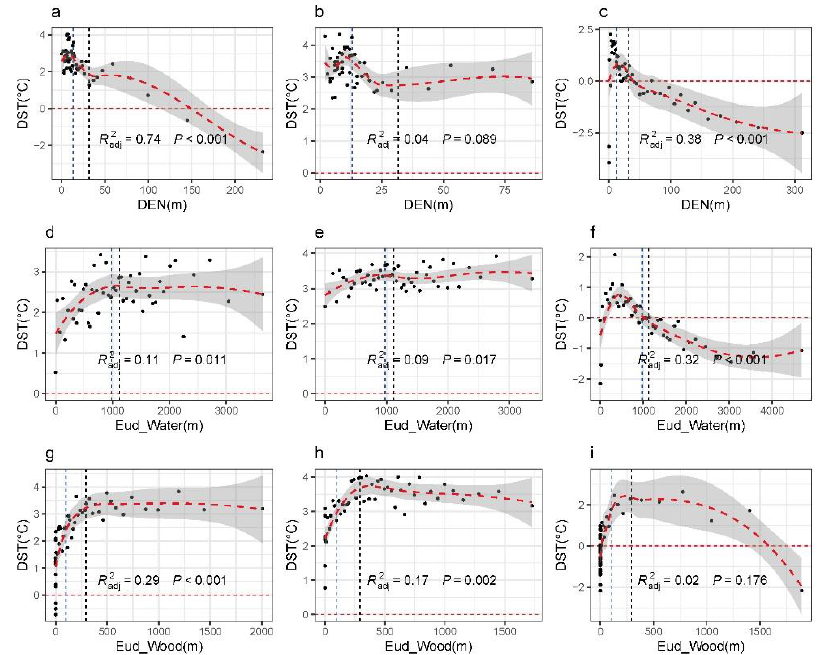
Figure 11. Single-factor scatter plots and fitting curves of DST to three surface location indicators. Subgraphs ( a , d , g ) are for the group of functions for A, G and R; ( b , e , h ) are for the group of functions for B, M, S and W; ( c , f , i ) are for Non-construction areas. The vertical blue dotted line is the median value and the black one is the mean value of the corresponding independent variables; the horizontal red dotted line is the zero value of DST.